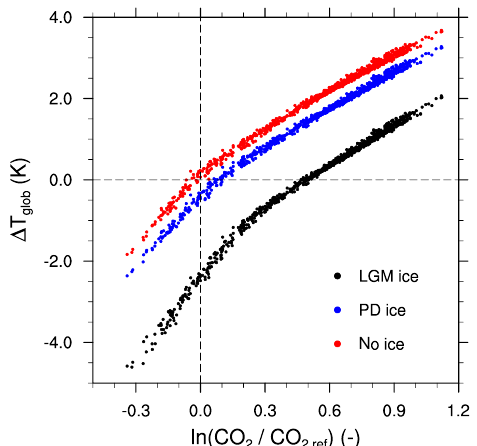
Figure 10. Relation between the logarithm of CO 2 divided by the PI value of 280ppm and global temperature anomalies with respect to PI (of the reference run) for the simulation with ice kept at PD level (blue dots), at LGM level (black dots), and the simulation with all land ice removed (red